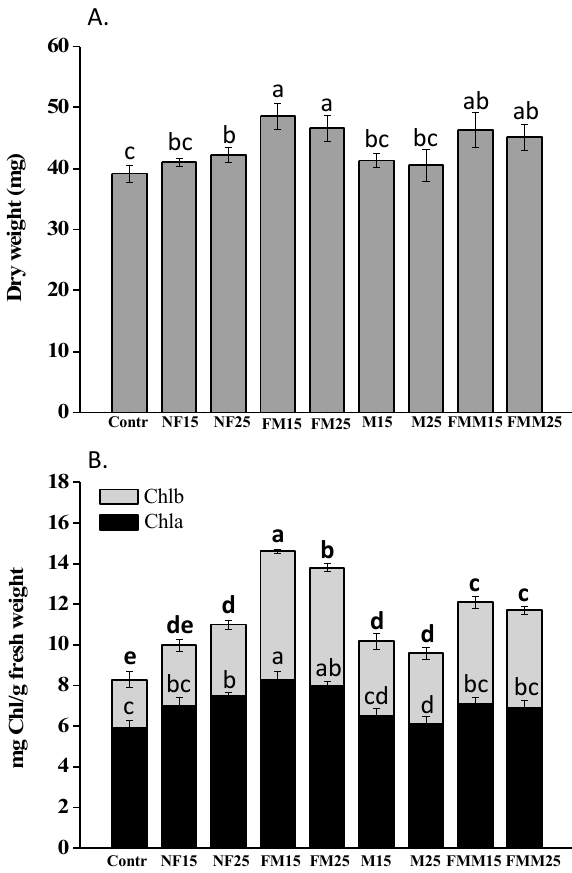
Figure 5. Dry weight ( A ) and chlorophyll content ( B ) of oat plant treated with HS extracted from earthworm coprolites collected in soils fertilized with no inputs (NF), or with manure (FM), mineral fertilizers (M) and with manure plus mineral fertilizers (FMM). HS were supplied for two days at two dosages, either 15 mg C/L or 25 mg C/L. Control plants (contr) were not added with HS. Data represent the means of three measurements. Values above bars following the same letter are not statistically different at p < 0.05 according to Student-Newman-Keuls test.